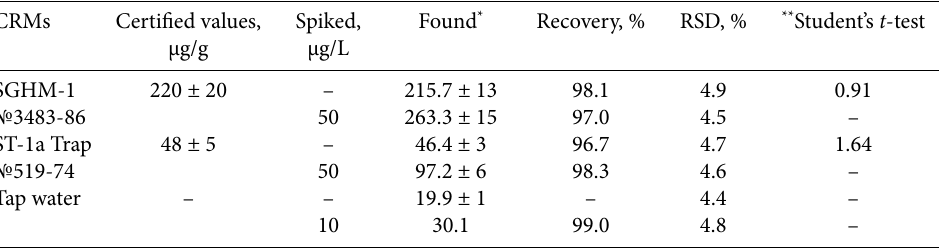
Table 3. Application of suggested procedure to the preconcentration and spectrophotometric determination of Cu(II) in CRM and tap water samples (n = 5; Р = 0.95) CRMs Certified values, Spiked, Found *